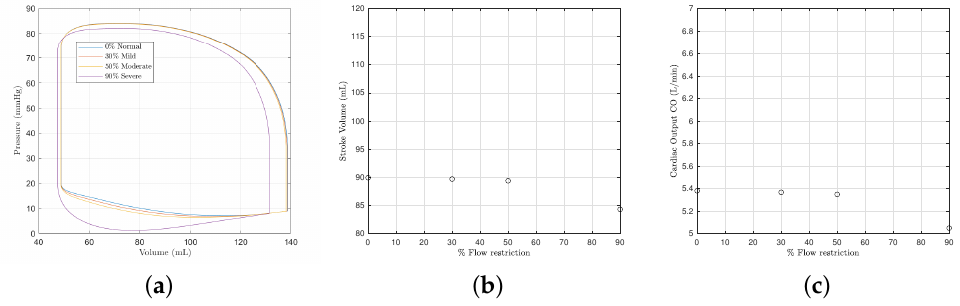
Figure 1. The left ventricle pressure–volume loop, the stroke volume, and the cardiac output with different severities of mitral valve stenosis. The model parameter values used to model each severity are provided in Table 4. ( a ) Pressure–volume loops. ( b ) The stroke volume SV. ( c ) The cardiac output